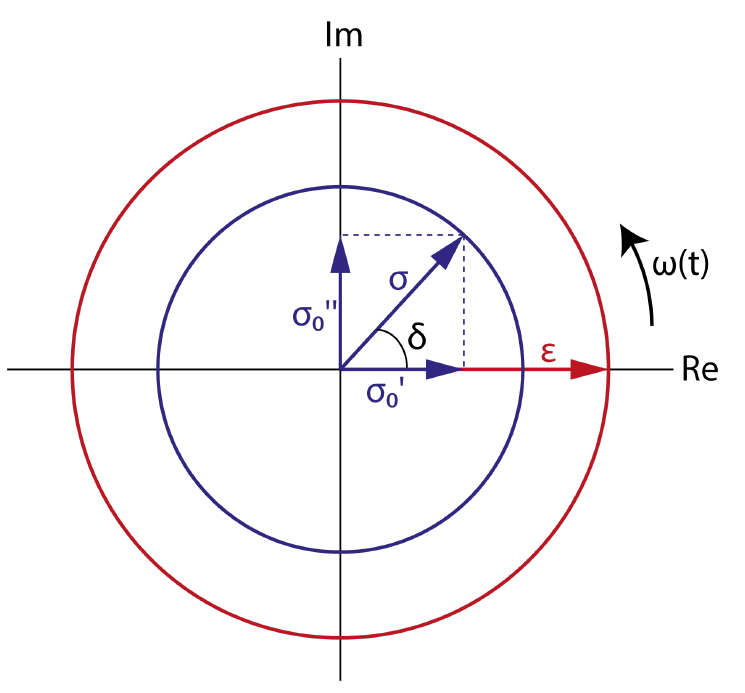
Figure 2. A representation of the harmonic stress and